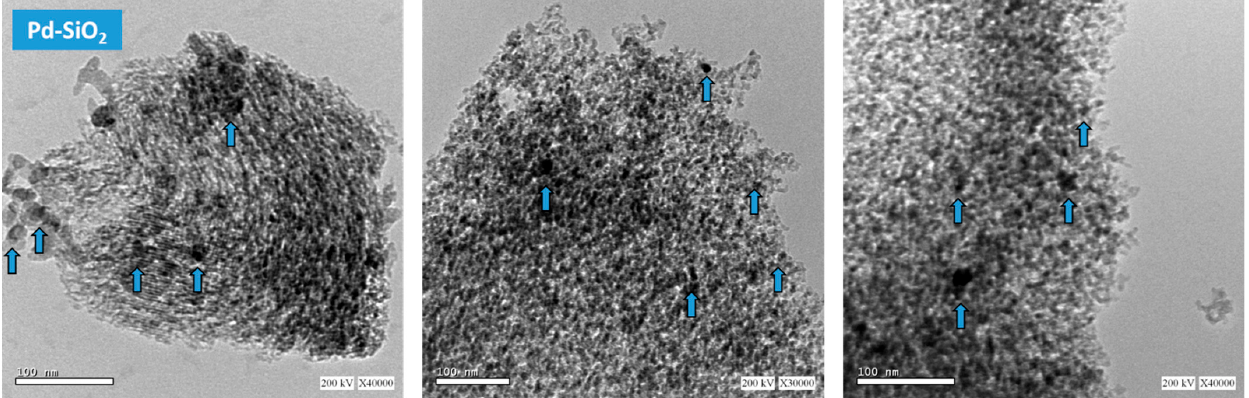
Figure 3. Different TEM images for the Pd-SiO 2 sample; arrows are pointing to the Pd